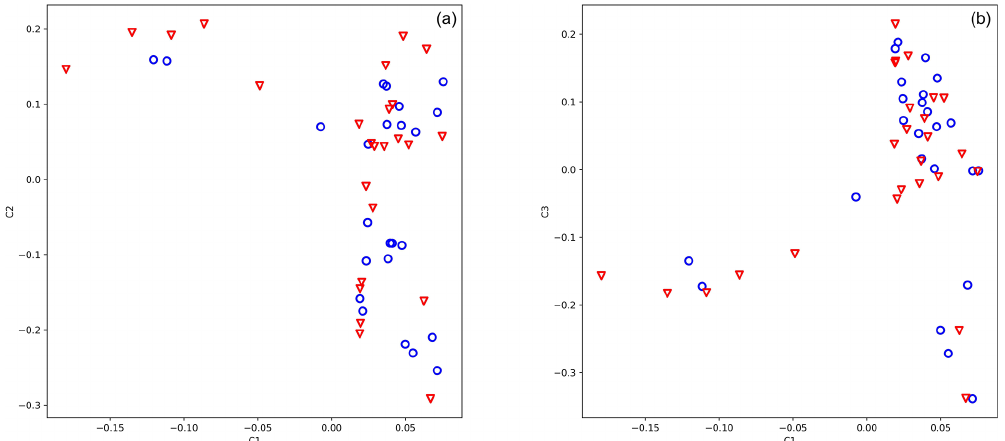
Figure 1. Principal component analysis of 49 stags based on their 583 loci. The blue circle shows animals with low antler quality, and the red triangle shows animals with high antler quality. Eigenvalues of axes C1 and C2 are 5.422 and 3.116, respectively.